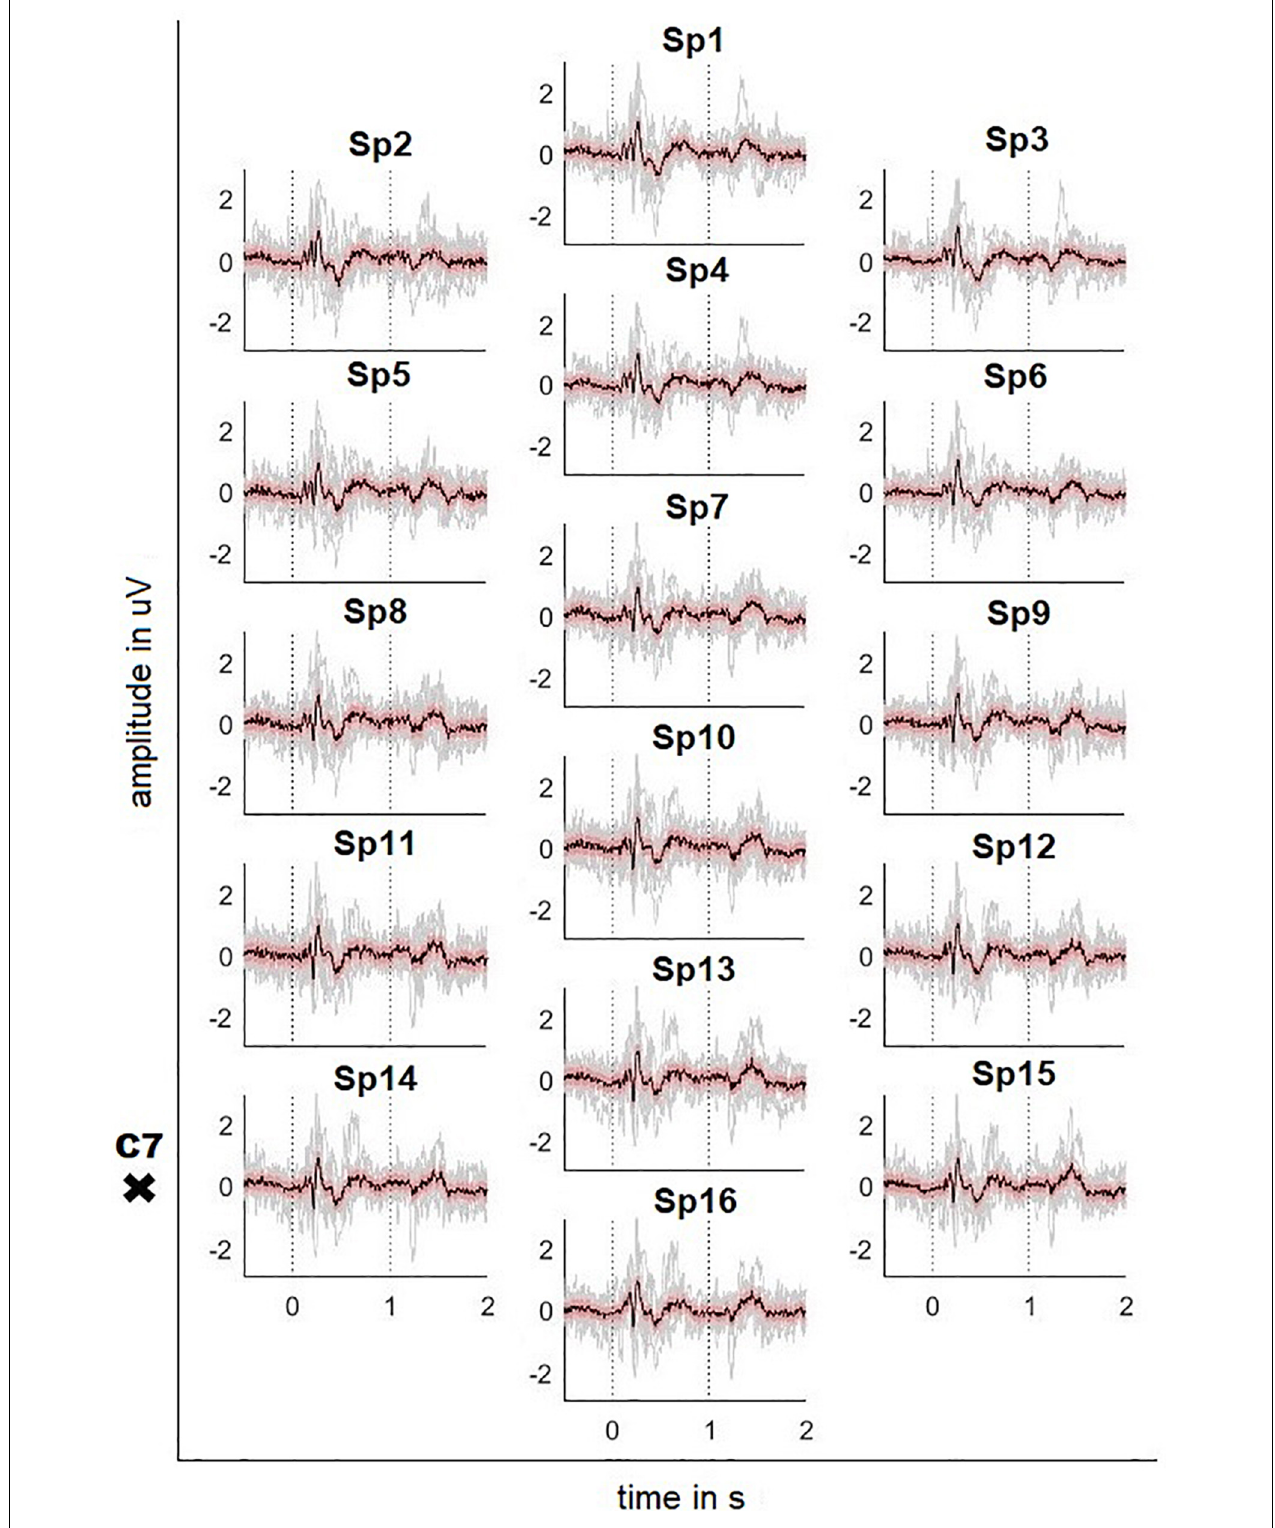
FIGURE 3 | Averaged SCP signals recorded on the neck with ± 2 standard error (red) and individual results of the 10 participants (gray). Dotted lines indicate the stimulus onset and offset. The position of the vertebra prominens is marked with a cross (electrode positions according to Figure 1C ).